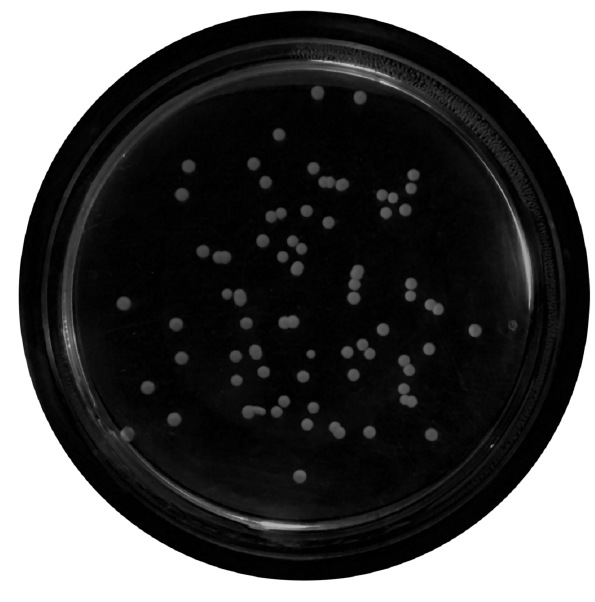
Figure 7. Top-hat transform with a disk structuring element.